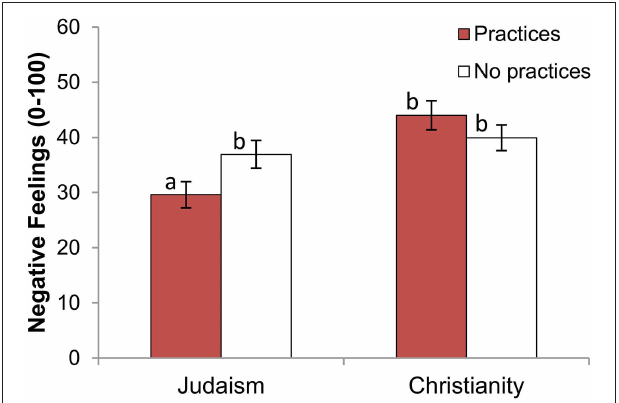
FIGURE 4 | Negative feelings toward target, by target religion and target level of practices (Jewish participants only). Error bars indicate ± 1 SE. Different subscripts indicate that these bars differ from each other at the p < 0 . 05 level.